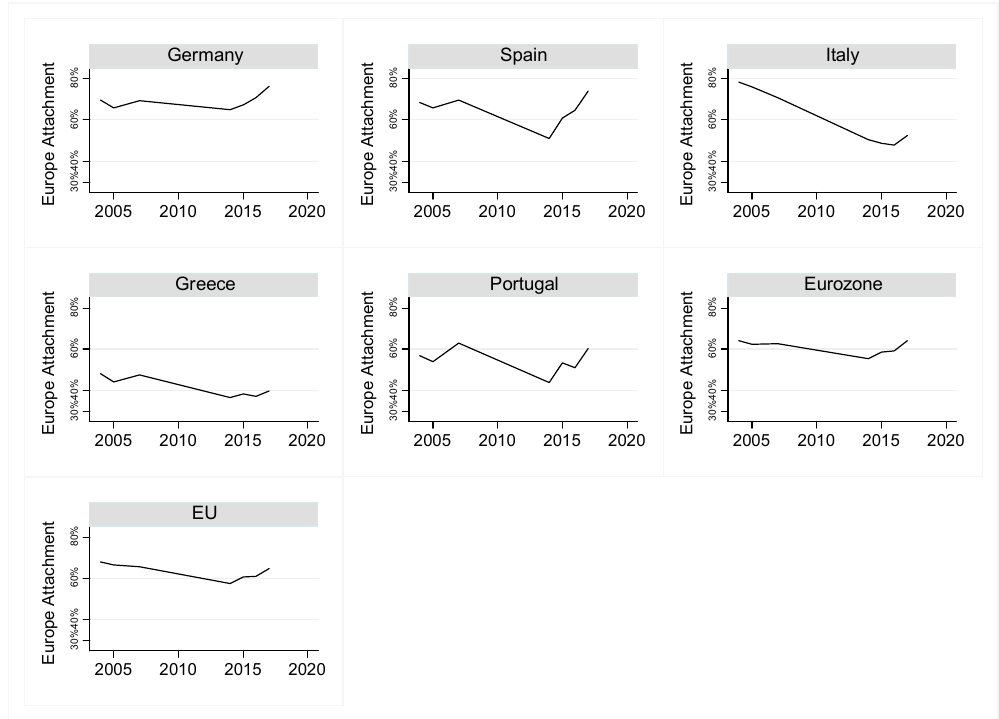
Figure 1. Evolution of attachment to Europe 2004–2017. Source: Own elaboration from Eurobarometer Note: Column percentage of attachment to Europe.